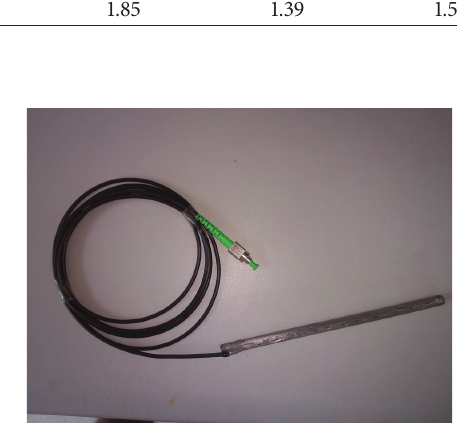
Figure 2: Model pipe pile with sensors packaged.